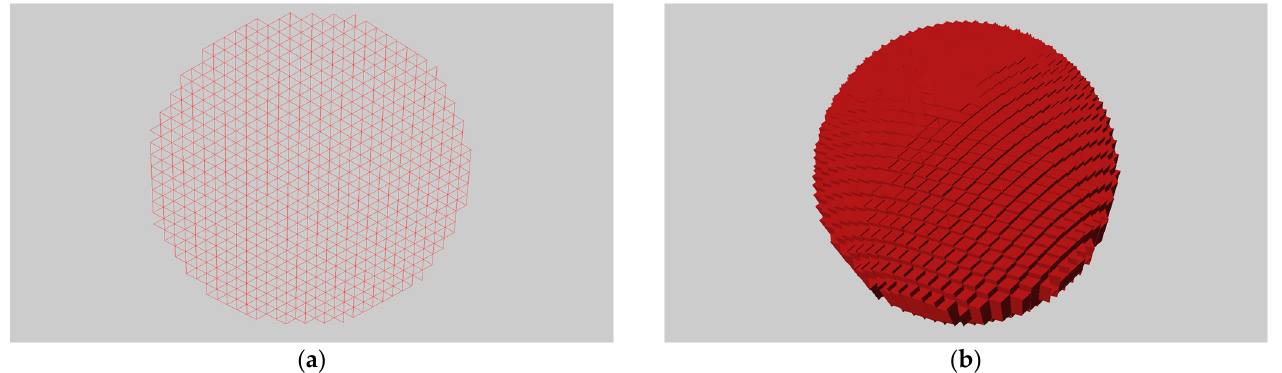
Figure 5. ( a ) The spherical 2D buffer of a point; ( b ) The sphere 3D buffer of a point.